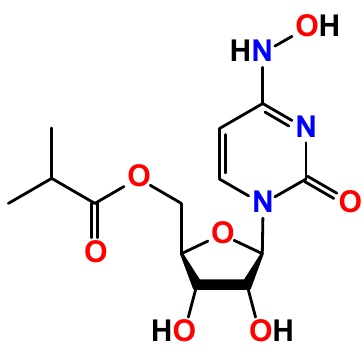
Figure 1. Diagram of molnupiravir.